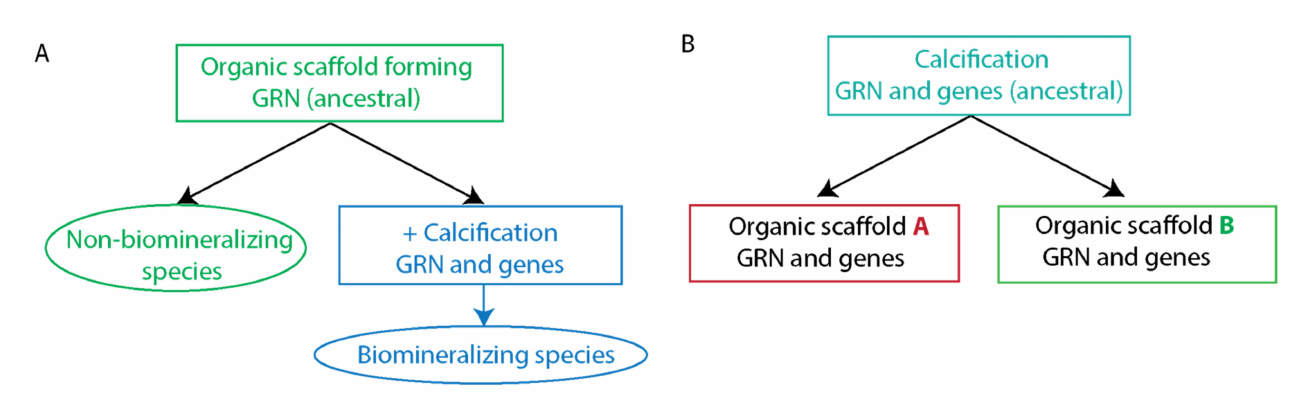
Figure 2. Possible models for the evolution of biomineralization GRNs from ancestral GRNs. ( A ), a model where an ancestral GRN that drove the formation of an organic scaffold was co-opted for biomineralization by activating regulatory and differentiation genes that assist in calcification. In this model we expect to see a strong similarity between the biomineralization of GRN to the GRN that drive the formation of the organic scaffold in non-biomineralization species. ( B ), a model where an ancestral GRN that drove the activation of genes that participate in calcification was co-opted for biomineralization through the activation of phylum specific regulatory and differentiation genes that control organic scaffold formation. In that case, we expect to see a similarity between the regulatory and differentiation genes that drive calcification in the two